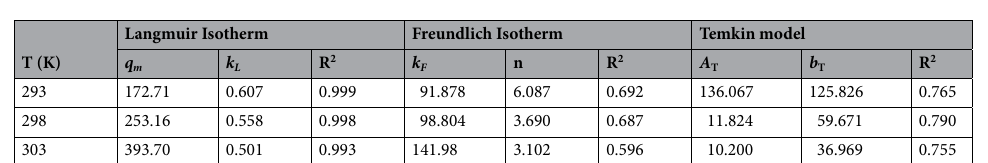
Figure 8. Langmuir model ( a ), Freundlich model ( b ) and Temkin model ( c ) of ZnNiAl-LDHs adsorption of U(VI).